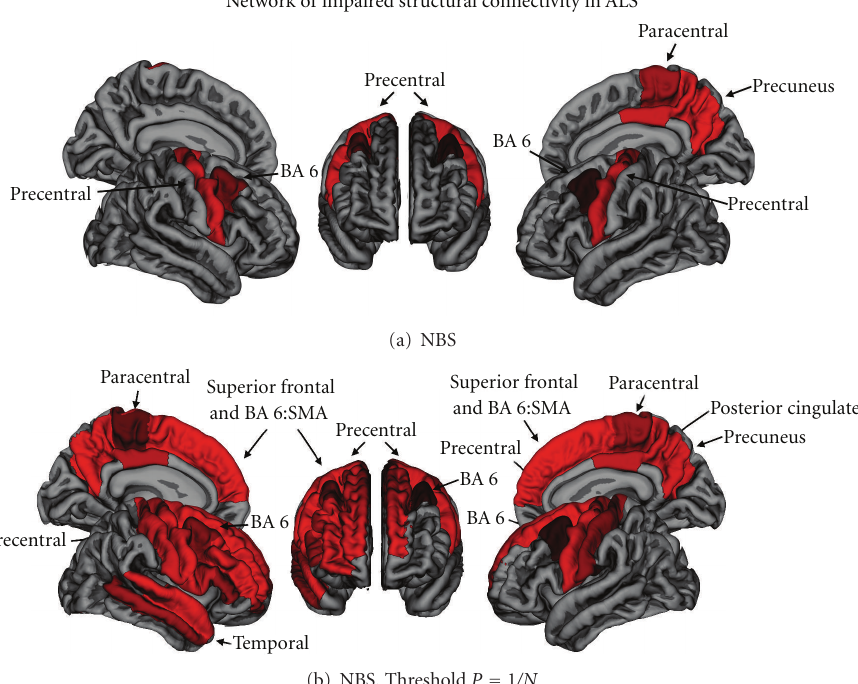
Figure 2: Cortical brain regions with impaired structural connectivity in ALS patients. (a) The network-based statistic procedure revealed a subnetwork of brain regions showing significantly reduced structural connectivity in ALS patients, compared to healthy controls. (b) Using an NBS threshold of P = 1 /N ( N being the number of nodes of the network) a similar but more extended network was revealed. The model- free approach revealed a sub-network consistent with known motor regions, including precentral and paracentral gyri (primary motor), and caudal middle frontal and superior frontal gyri (supplemental motor areas, BA 6). Adapted from Verstraete and coworkers